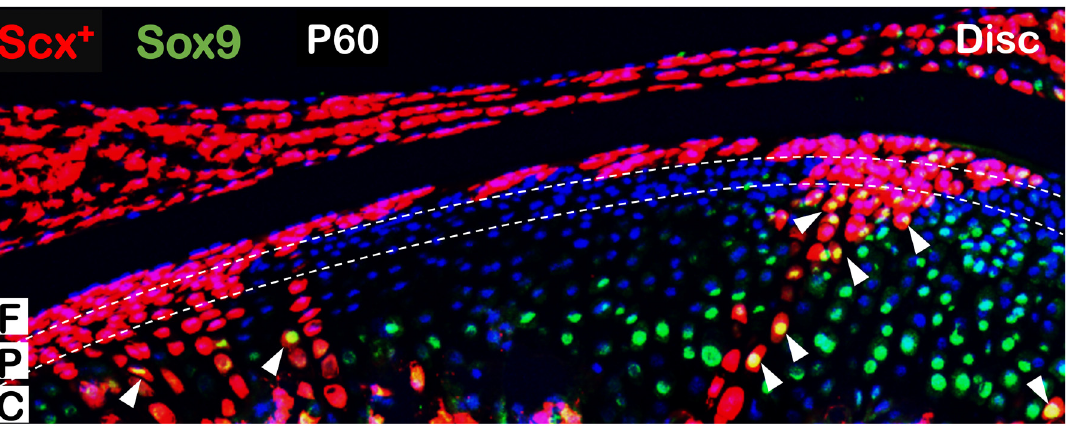
Figure 3. A subset of early labeled Scx + cells contribute to postnatal condyle head expansion. 2 Tamoxifen was injected at P3 and mice were harvested at P60. There were a number of Tomato + cells accumulated into clusters that extended from the fibrous to chondrocytic layers with Sox9 expression (immunofluorescence signal in green color, arrow heads indicating its co-localization with tomato signal) in nuclei. F: fibrous layer; P: prechondroblast layer; C: chondrocytic